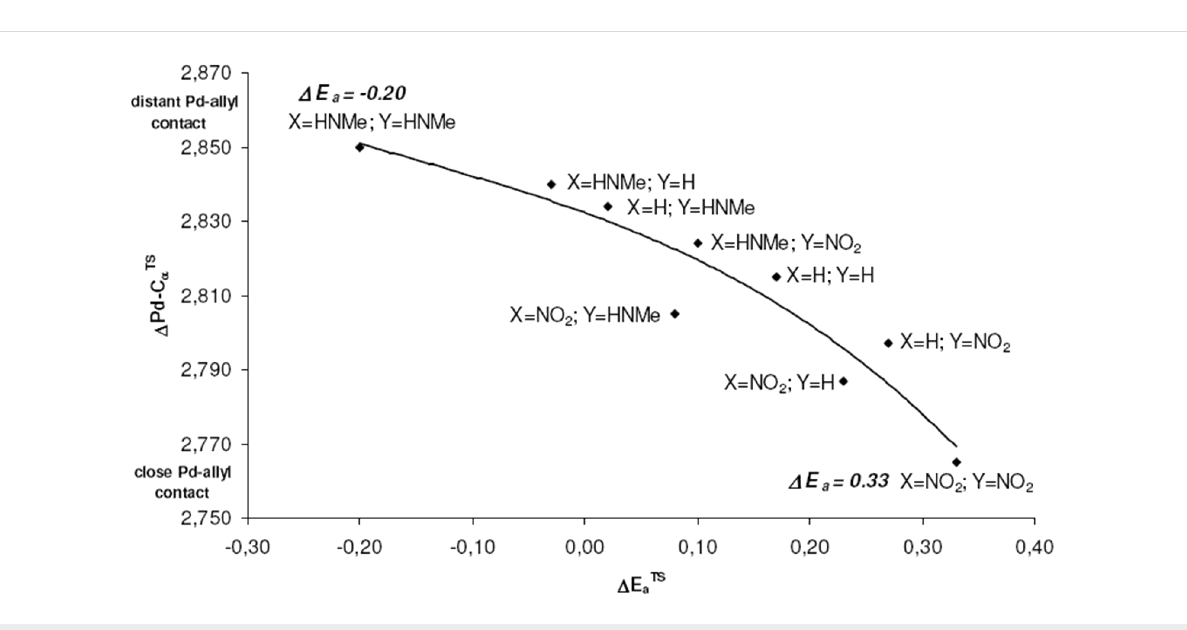
Figure 11: Higher site selectivities, i.e. larger ΔE aTS values, are found for transition structures with closer, more intense Pd-C α